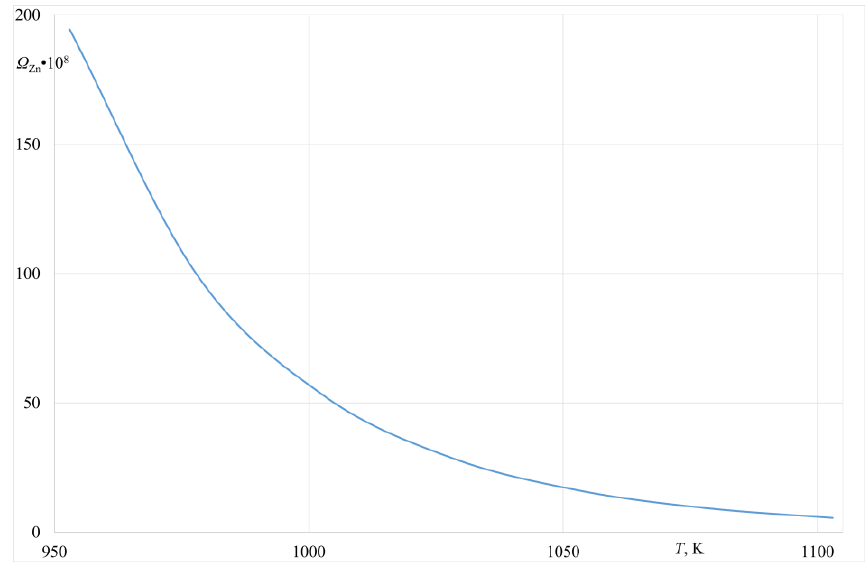
Figure 3. Ω ratio for the Al-Zn alloy (6.3% wt.% Zn). Figure 3. Ω ratio for the Al-Zn alloy (6.3% wt.% Zn). Figure 3. Ω ratio for the Al-Zn alloy (6.3% wt.% Zn).